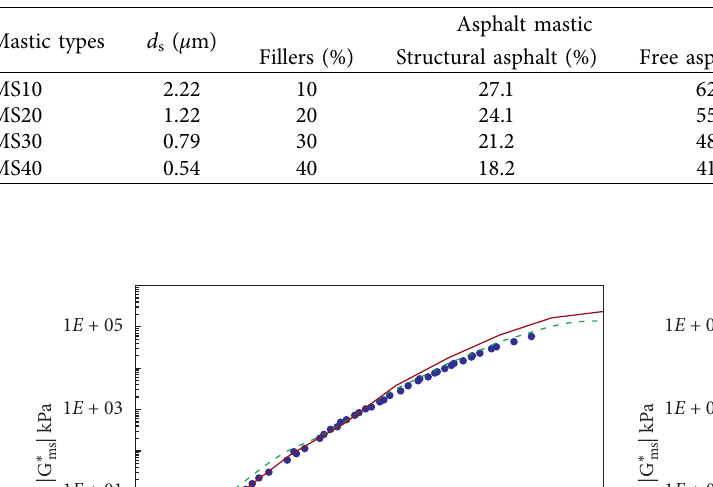
Table 1: Thickness of structural asphalt layer and volume fraction of each component.